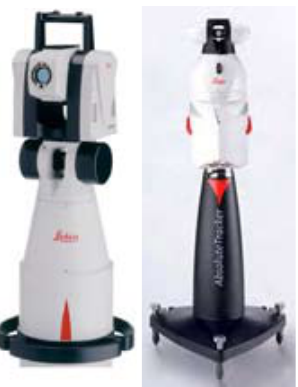
fig. 3. Leica Laser Tracker LTD 840 and Absolute Tracker AT901. Pictures from EMO Hannover and Magazine